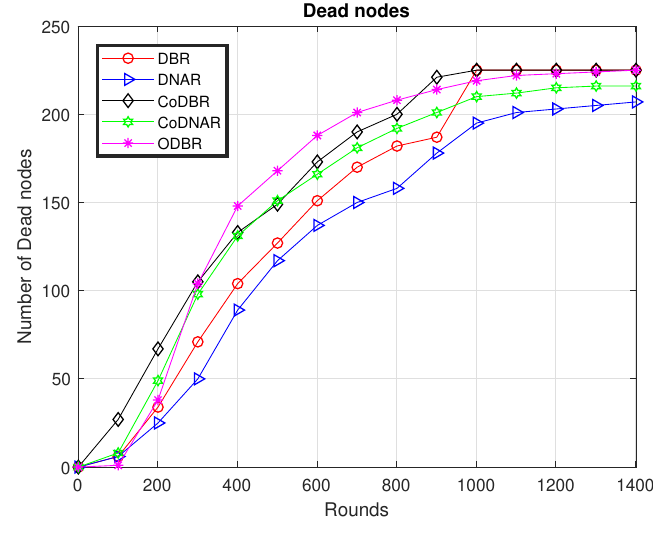
Figure 14. Total numbers of dead